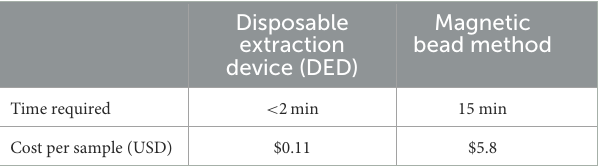
TABLE 3 The time required and cost for the disposable extraction device (DED) and the magnetic bead